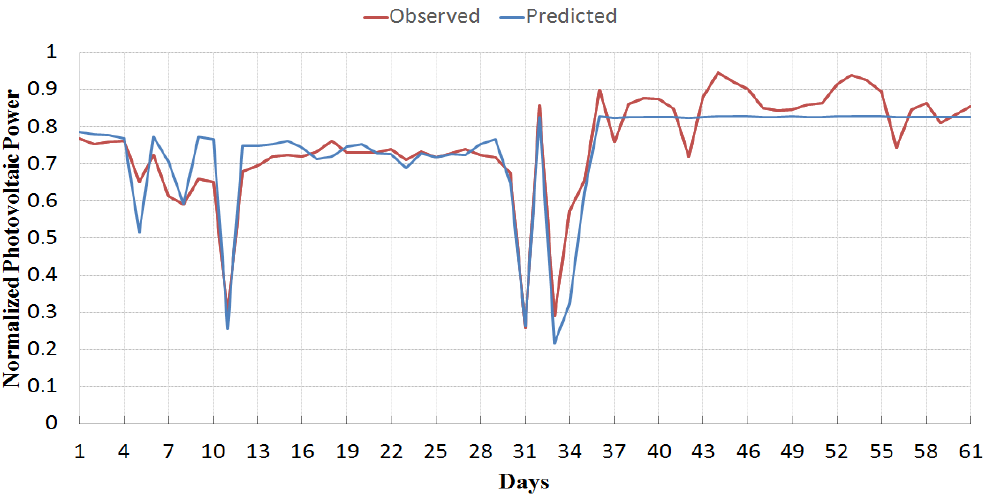
Figure 7. The predicted photovoltaic power values of the ALO-MLP method, which used T A , SR TH , and SR DH inputs.